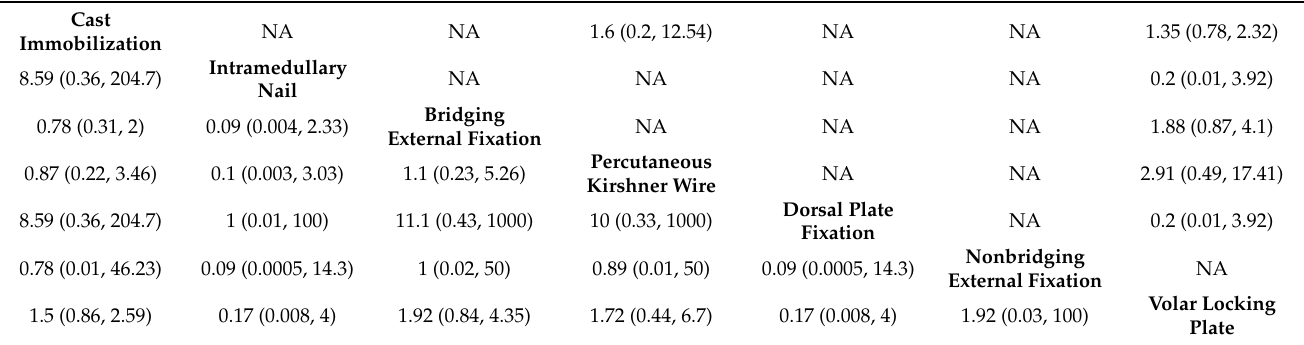
Table 6. Absolute and relative RR estimates (95% CI) on major complications (*). Upper right triangle gives the mean difference from pairwise comparisons (column intervention relative to row) and lower left triangle gives the mean difference from the network meta-analysis (row intervention relative to column).